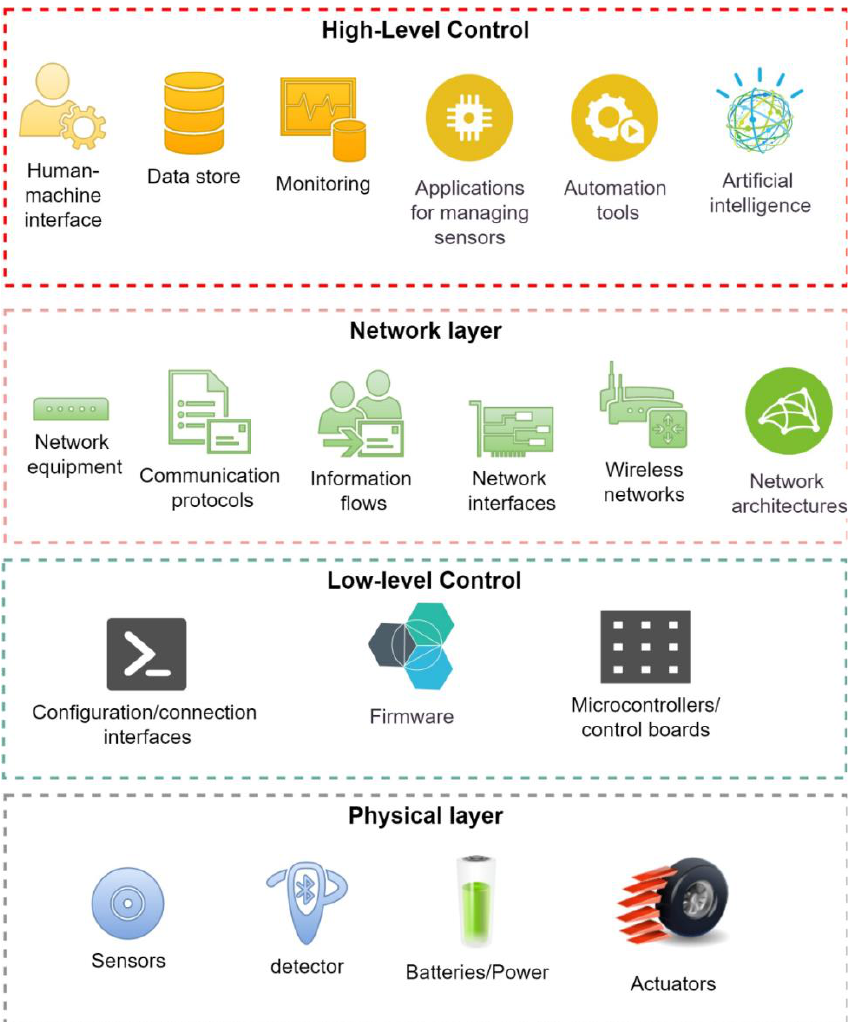
Figure 1. CPS architecture from the point of view of the functional model.